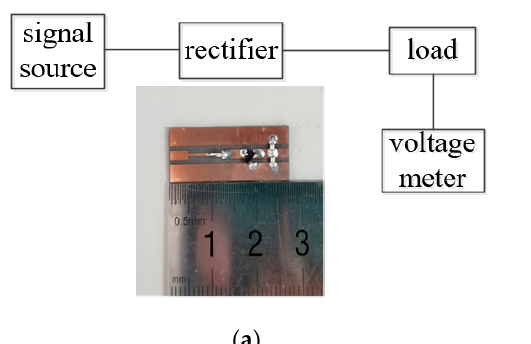
Figure 6. Measurement system of the rectifier: ( a ) schematic ( b ) actual.